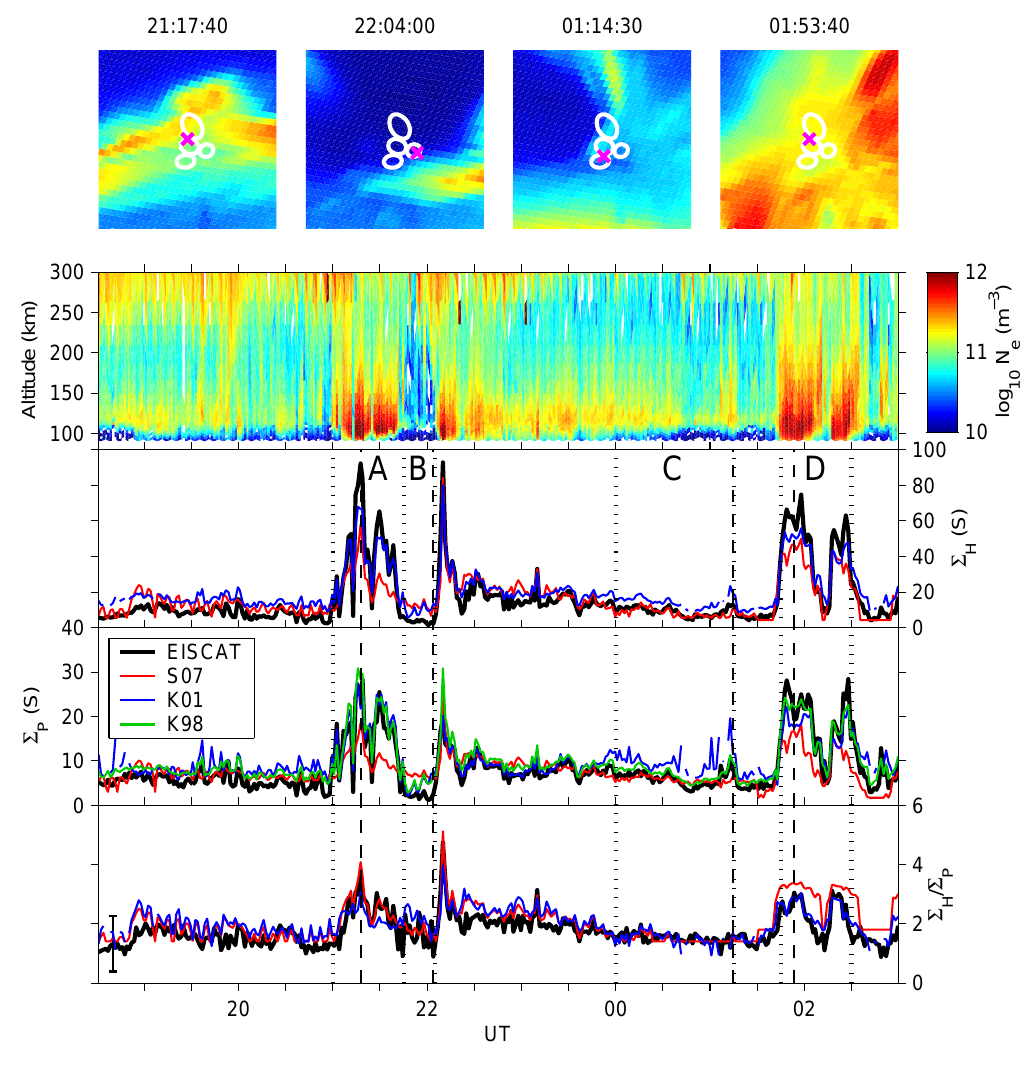
Fig. 3. Data from 8/9 March 1999 (Case 1). The methods are identified by the line colours which are labelled in the fourth row. The dotted vertical lines mark intervals of interest which are labelled in the third row. The dashed vertical lines mark the times of the images in the top row. Top row: 557.7nm images. The intensity scale covers the range of the data in each image and the intensities have been compressed by taking the square-root to reveal weaker features. The white rings indicate the − 3dB contours of a subset of IRIS beams. The pink crosses indicate the EISCAT UHF beam direction. The images are presented in AACGM co-ordinates (latitudes 64.83–67.83, longitudes 100.62–106.62) with north to the top and east to the right. Second row: electron densities from the EISCAT UHF radar. Third row: Hall conductances. Fourth row: Pedersen conductances. Bottom row: Hall/Pedersen conductance ratio. The one standard error bound is shown by error bars where the error exceeds